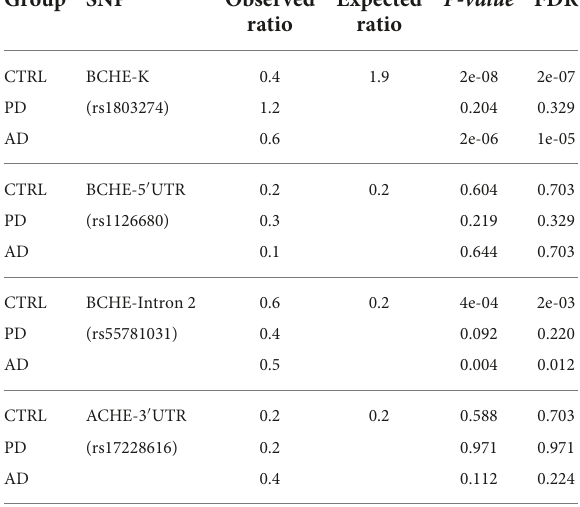
TABLE 1 Control, AD, and PD groups show distinct distribution of the three BCHE SNPs from GTEx healthy donors. Group